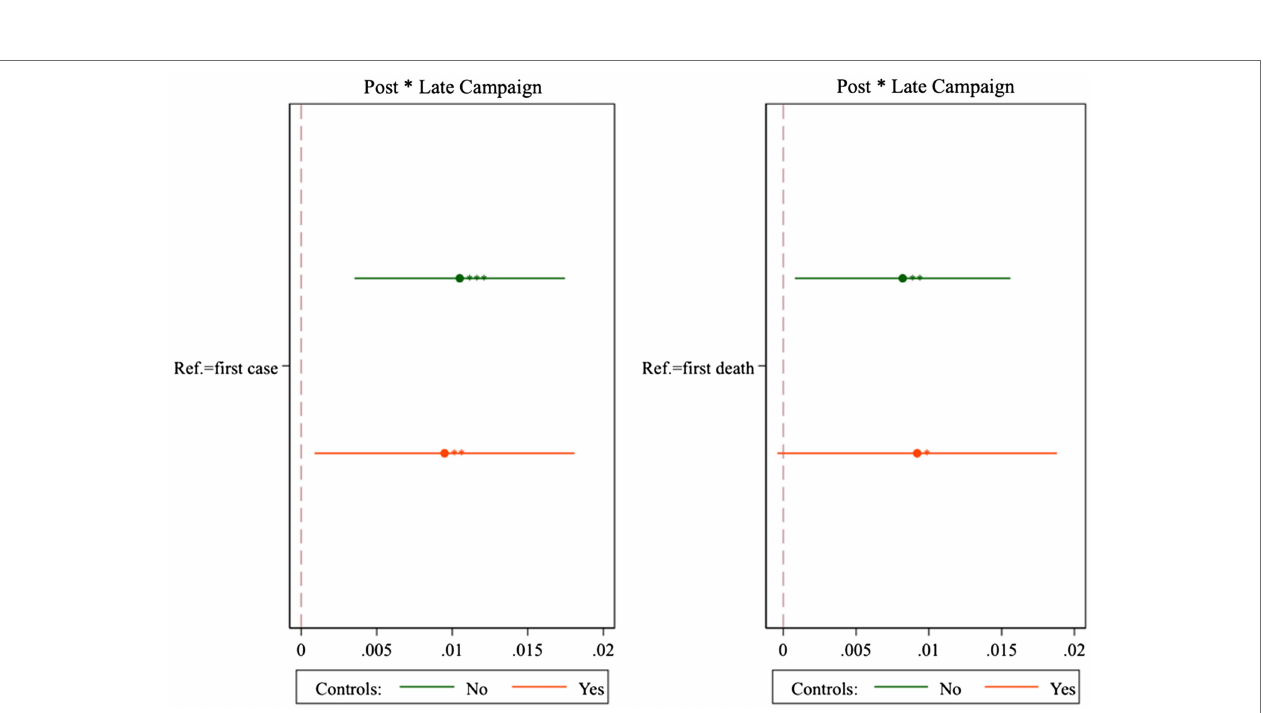
FIGURE 4 | Coefficients and 95% CIs of Post * LC from Equation